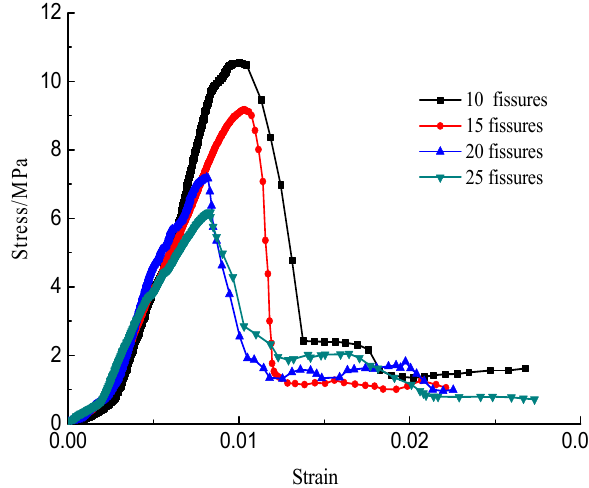
Figure 11. Stress–strain curves with a crack angle of 45°.